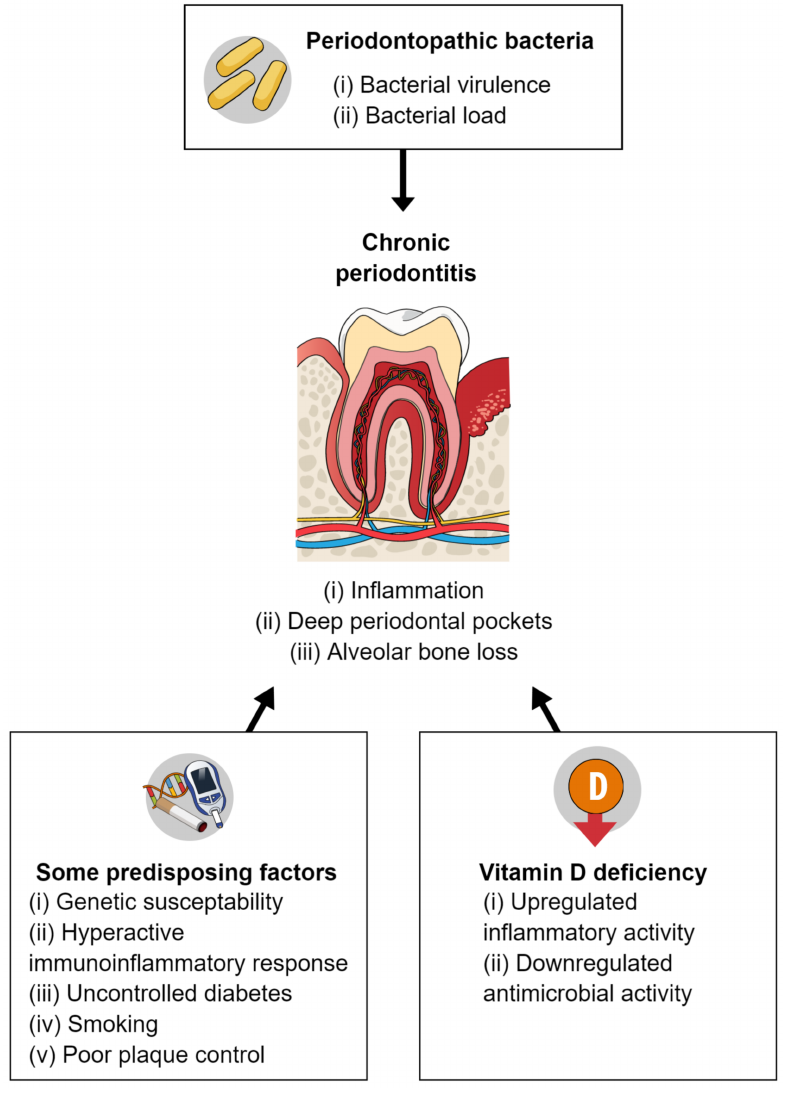
Figure 2. Pathogenesis of periodontal disease and a possible relationship with vitamin D